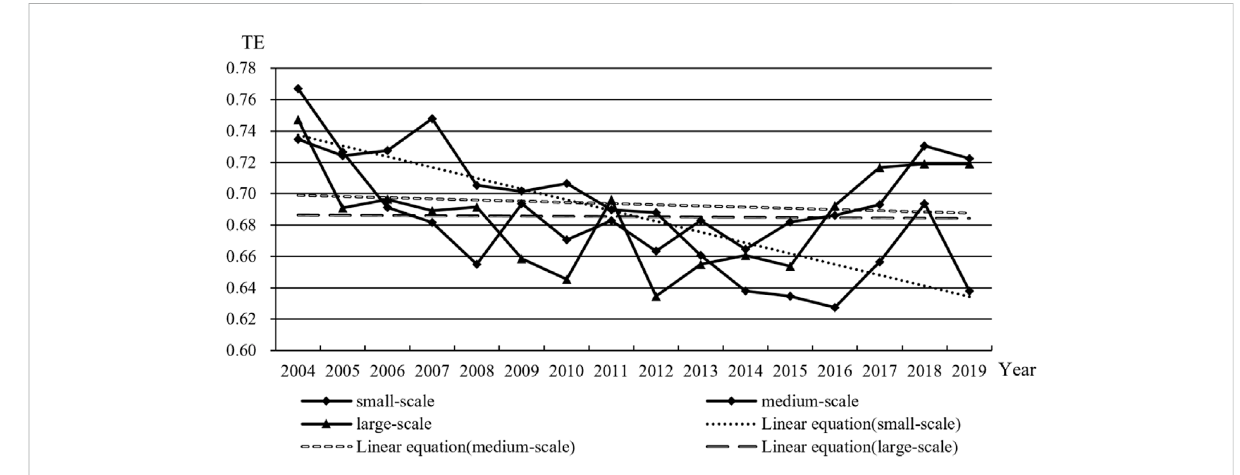
FIGURE 1 Variation trend of environmental ef fi ciency of dairy farming on different scales in China from 2004 to